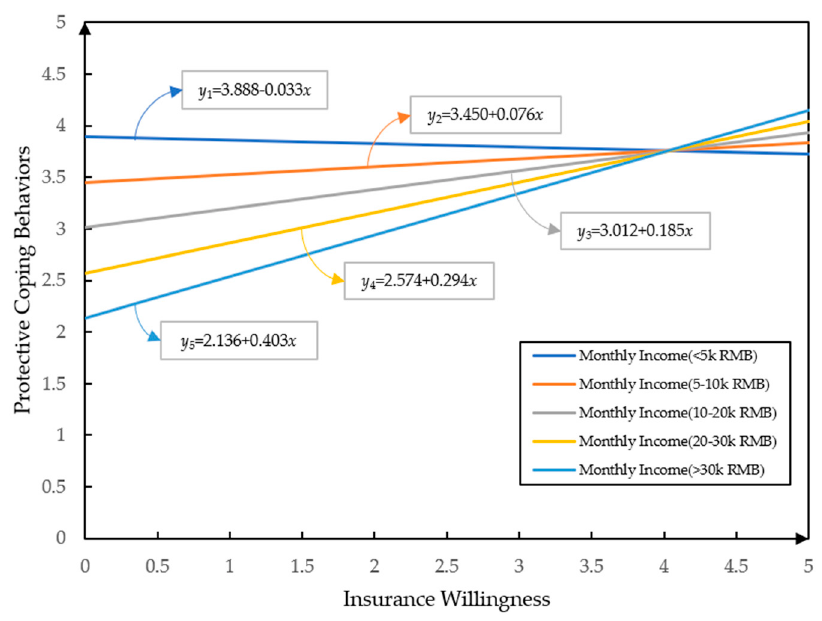
Figure 3. The interaction effect of monthly income and insurance willingness. Note: y represents protective coping behaviors, x represents insurance willingness.